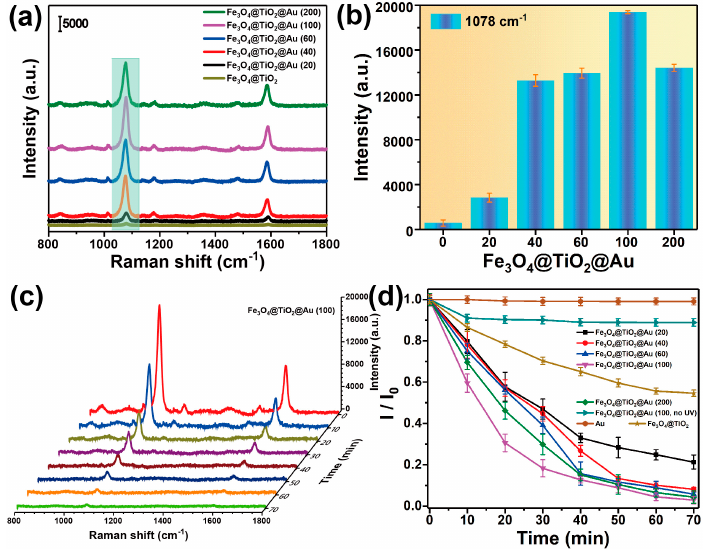
Figure 4. ( a ) SERS spectra of 4MBA on the Fe 3 O 4 @TiO 2 @Au nanocomposites synthesized with different volumes of Au seeds; and ( b ) columnar distribution of the SERS intensity at 1078 cm − 1 ; ( c ) SERS spectral change of 4MBA on Fe 3 O 4 @TiO 2 @Au nanocomposites synthesized with 100 mL of Au seed soluiton during UV light irradiation; ( d ) Photocatalytic degradation of 4MBA (exampled by I / I 0 of SERS peak at 1078 cm − 1 ) in aqueous suspension of Au, Fe 3 O 4 @TiO 2 , and various Fe 3 O 4 @TiO 2 @Au nanocomposites with and without UV